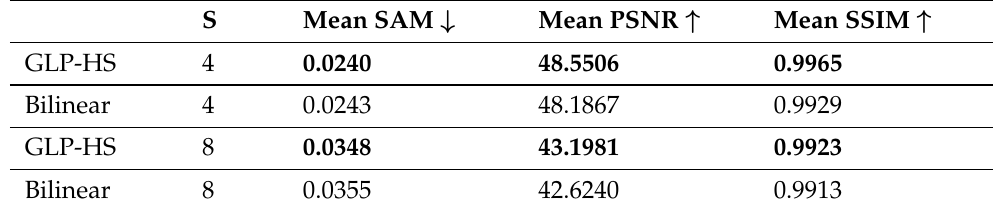
Table 4. The effect of using different up-sampling methods to initialize the preliminary HR-VNIR-HSI. The up-arrow means the higher the value, the better the performance. The down-arrow means the lower the value, the better the performance. The best performances are highlighted in